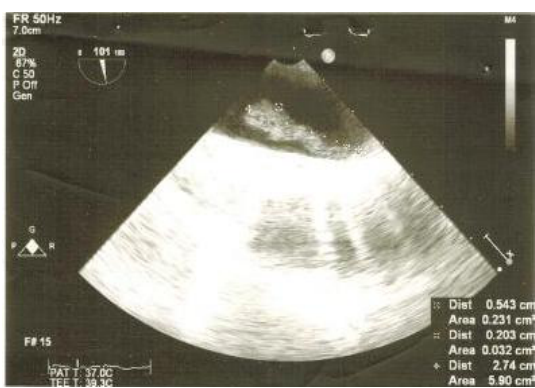
Figure 2 .Another picture of thrombosis in descending aorta. no significant neurologic